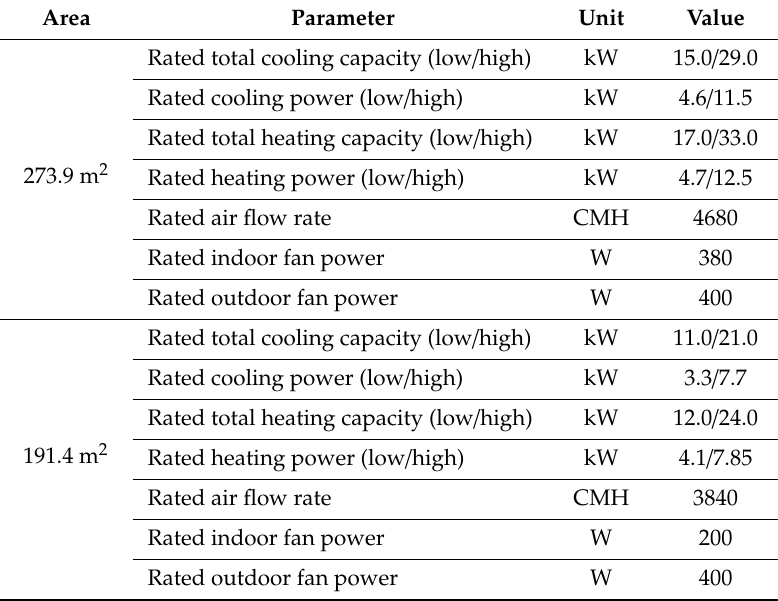
Table 8. Heat-pump specifications applied to the standard building.